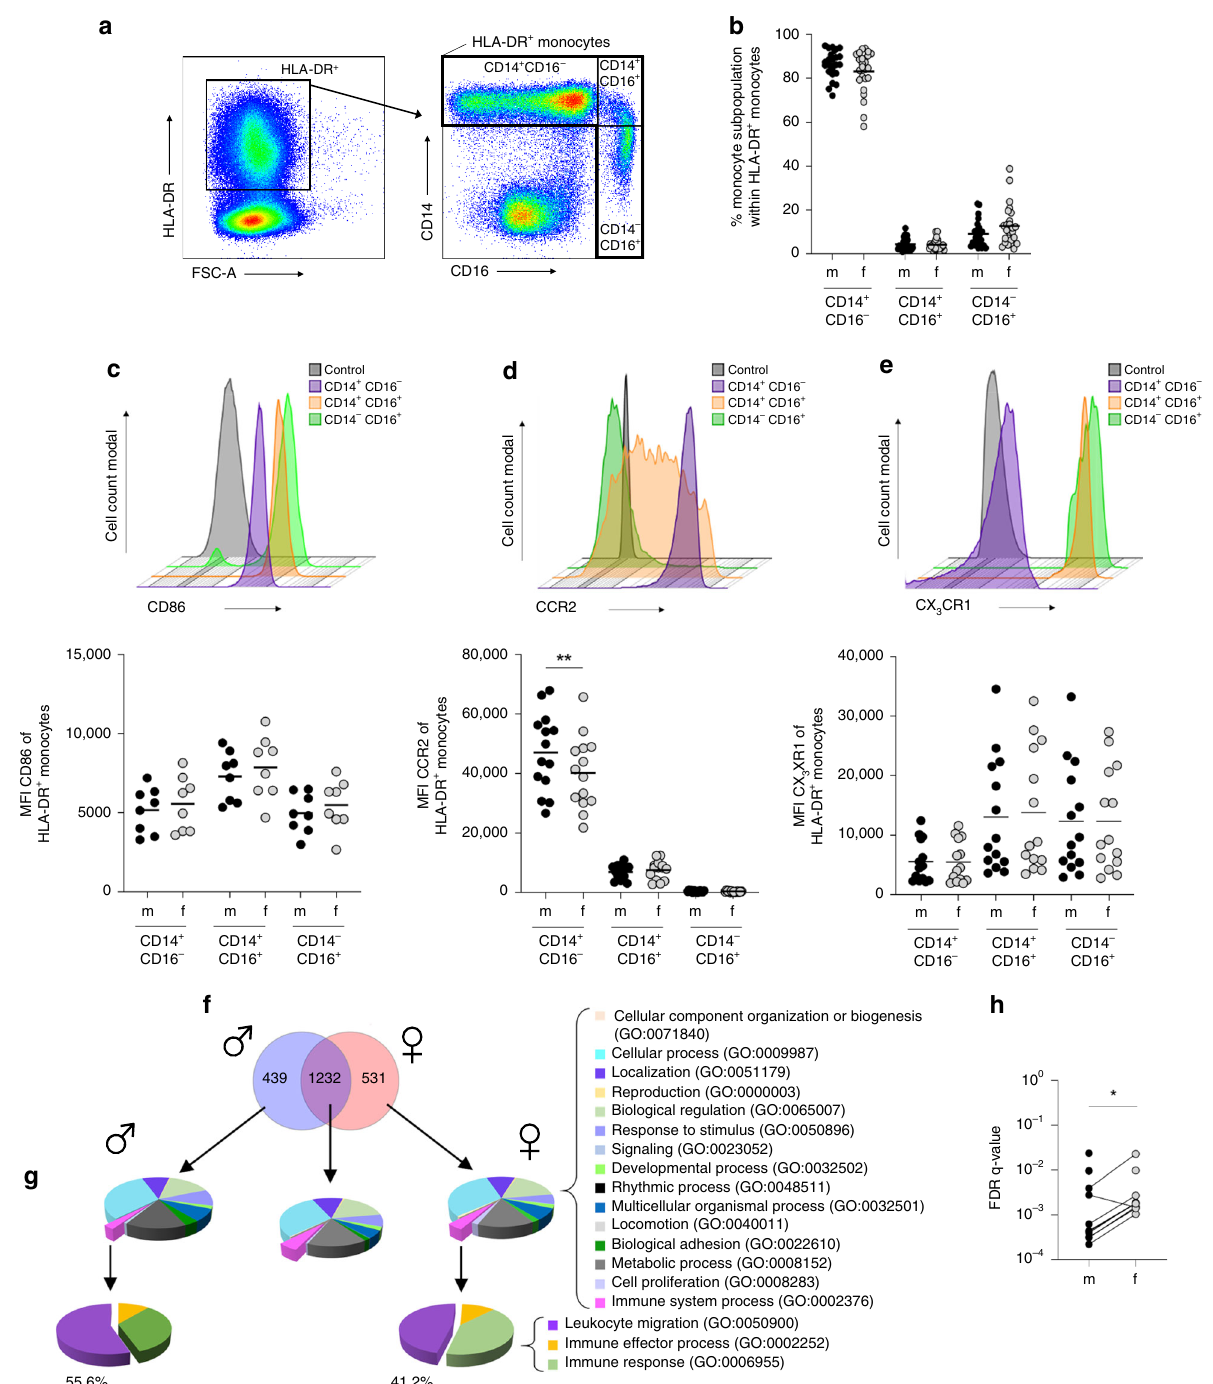
Fig. 3 Monocytes from healthy men show stronger expression pro fi le for migration. a Gating strategy to identify monocyte subsets in healthy human blood donors. b Percentage of classical (CD14 + CD16 − ), intermediate (CD14 + CD16 + ), and non-classical (CD14 − CD16 + ) monocytes in the peripheral blood of healthy men and women ( n m/f CD14 + CD16 − = 24/25; n m/f CD14 + CD16 + = 24/25; n m/f CD14 − CD16 + = 24/25; pooled data from samples collected over a time frame of nine months; depicted are the means). Histogram and graphs showing the MFI of c CD86, d CCR2, and e CX 3 CR1 on peripheral monocyte subpopulations from healthy male and female human blood donors ( c n m/f CD14 + CD16 − = 8; n m/f CD14 + CD16 + = 8; n m/f CD14 − CD16 + = 8; d n m/f CD14 + CD16 − = 14; n m/f CD14 + CD16 + = 14; n = 14; e n = 14; n = 14; n = 14; pooled data of samples collected over a time frame of nine months; m/f CD14 − CD16 + m/f CD14 + CD16 − m/f CD14 + CD16 + m/f CD14 − CD16 + Depicted are the means). f Transcriptome analysis of CD14 + monocytes from men and women. PBMCs from male ( n = 4) and female ( n = 3) healthy donors (25 – 49 years of age) were stimulated with LPS, and CD14 + monocytes were isolated using MACS. RNA was isolated, transcribed into cDNA, and subjected to RNA Seq analysis. Venn diagram showing differentially regulated genes from men and women following LPS stimulation compared with the corresponding medium control (log2FoldChange>2 and a padj value<0.05). g PANTHER GO-slim analysis of biological processes, and h FDR- q values of GO terms connected to leukocyte migration in men and women conducted with GOrilla analysis(Table 1). P -values were calculated using two-tailed paired analysis; Wilcoxon matched-paired signed rank test ( d , h ), * P <0.05; **P<0.01. Source data are provided as a Source Data fi